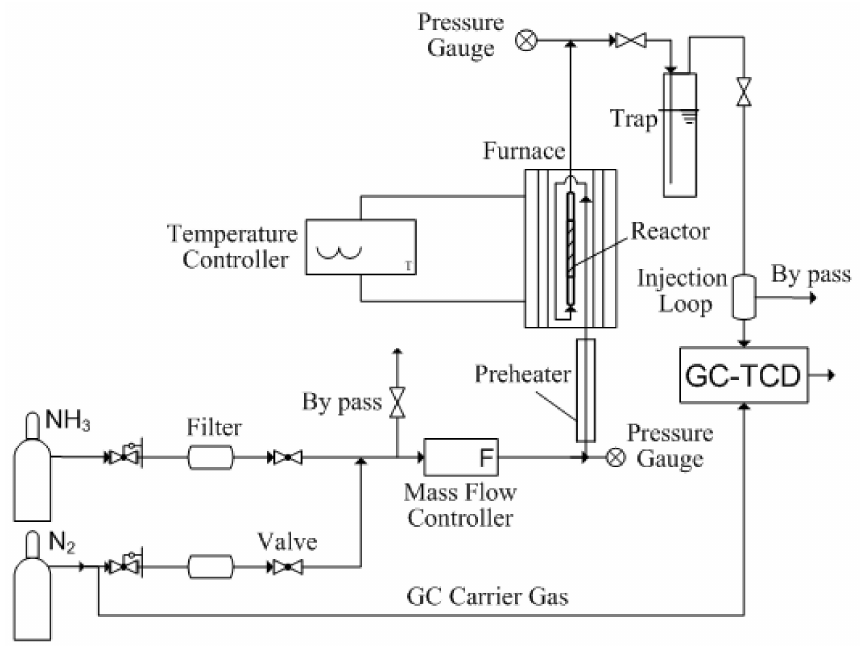
Figure 10. A schematic diagram of the experimental setup for the ammonia decomposition perfor- mance measurement system in a fixed-bed